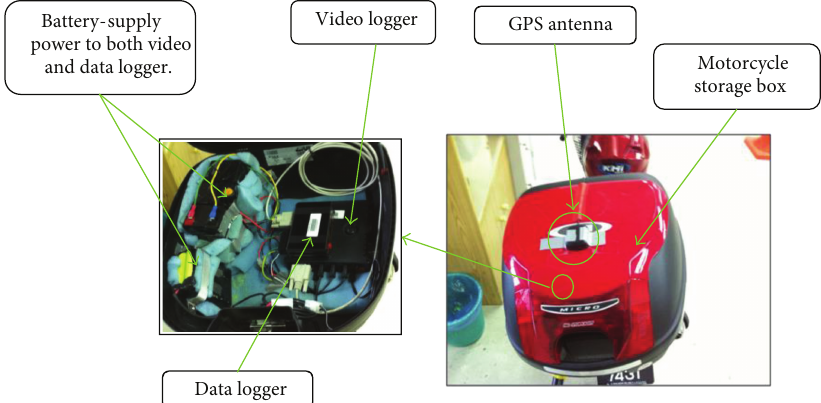
Figure 2: Installation of data logger, video logger, and GPS antenna on the instrumented motorcycle.